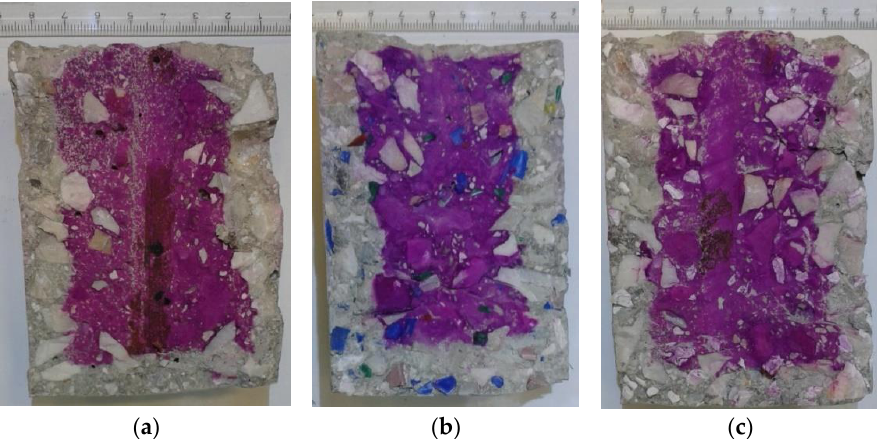
Figure 6. Inner surface of concrete specimens: ( a ) RM, ( b ) HDPE, and ( c ) PP concrete specimens. Multiple measurements were performed in each specimen. All measurement results within specimens are drawn from a normal distribution (according to a Shapiro – Wilk test [32]). Additionally, no outliers were found in each of these measurement datasets (accord- ing to a box-plot analysis). The uncertainty on the mean carbonation depth for each spec- imen, shown in the next table, is a type A, expanded uncertainty (k = 2), estimated based on the standard error of more than 10 measurements per specimen. For each of the three types of specimens (reference and with PP or HDPE addition), a weighted mean was es- timated using the inverse variance as a weighing factor. The presented uncertainty for these estimations is the combined uncertainty from three individual mean values coming from each specimen type. By performing a Kruskal – Wallis test [33] on the 3 × 3 = 9 means of carbonation depth, it was concluded that none of the specimen types dominate over any other. Therefore, according to this measurement dataset, the factor of thermoplastic addition cannot be characterized significantly as a modifier of the mean carbonation depth for the tested specimens. 3.2. Volume of Permeable Pore Space As it is shown in Figure 6 that all specimens from the three mixes present the same image. Near the rebar, there is no carbonation, and near the specimen surface, carbonation is observed. Therefore, samples were taken from those two different areas. Four samples were taken from near the surface area, and seven samples were taken from near the rebars area. The volume of permeable pore space was found to decrease when carbonation has taken place (Table 3). This is attributed to the fact that during carbonation, secondary formed calcite is deposited on the inside of pores but also at their entrance, thus making some of those impermeable [34]. In all cases (reference and specimens containing thermo- plastic waste — PP or HDPE), this decrease was found equal to approximately 4%. These differences were tested and found significant at a 95% significance level, according to a two-sample t -test. Table 3. Volume of permeable pore space and testing on the effect of carbonation on its value. Sample’s Area